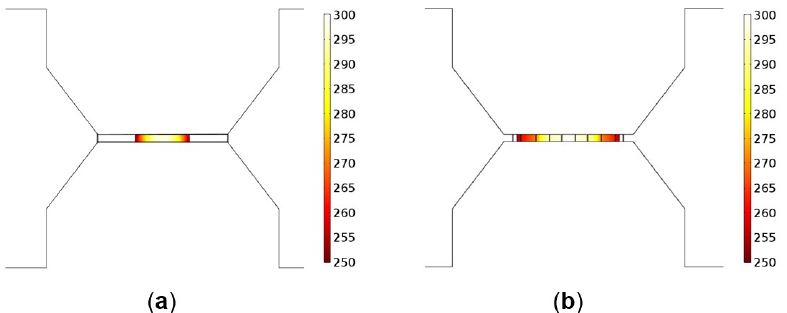
Figure 5. Temperature distribution ( ◦ C) over the active area of ( a ) the initial D02 design and ( b ) the novel composite heater